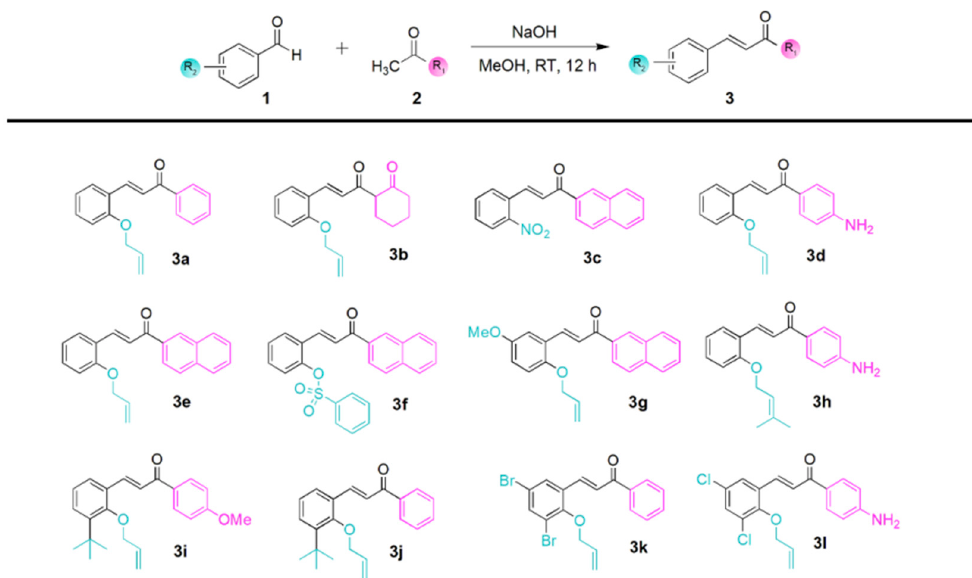
Figure 1. Synthesis of CAH derivatives ( α , β -unsaturated ketones) from Claisen–Schmidt condensa- tion of oxygenated acetophenones. Substrate scope and structures of CAH derivatives ( 3a – 3l ) are shown in the lower panel.